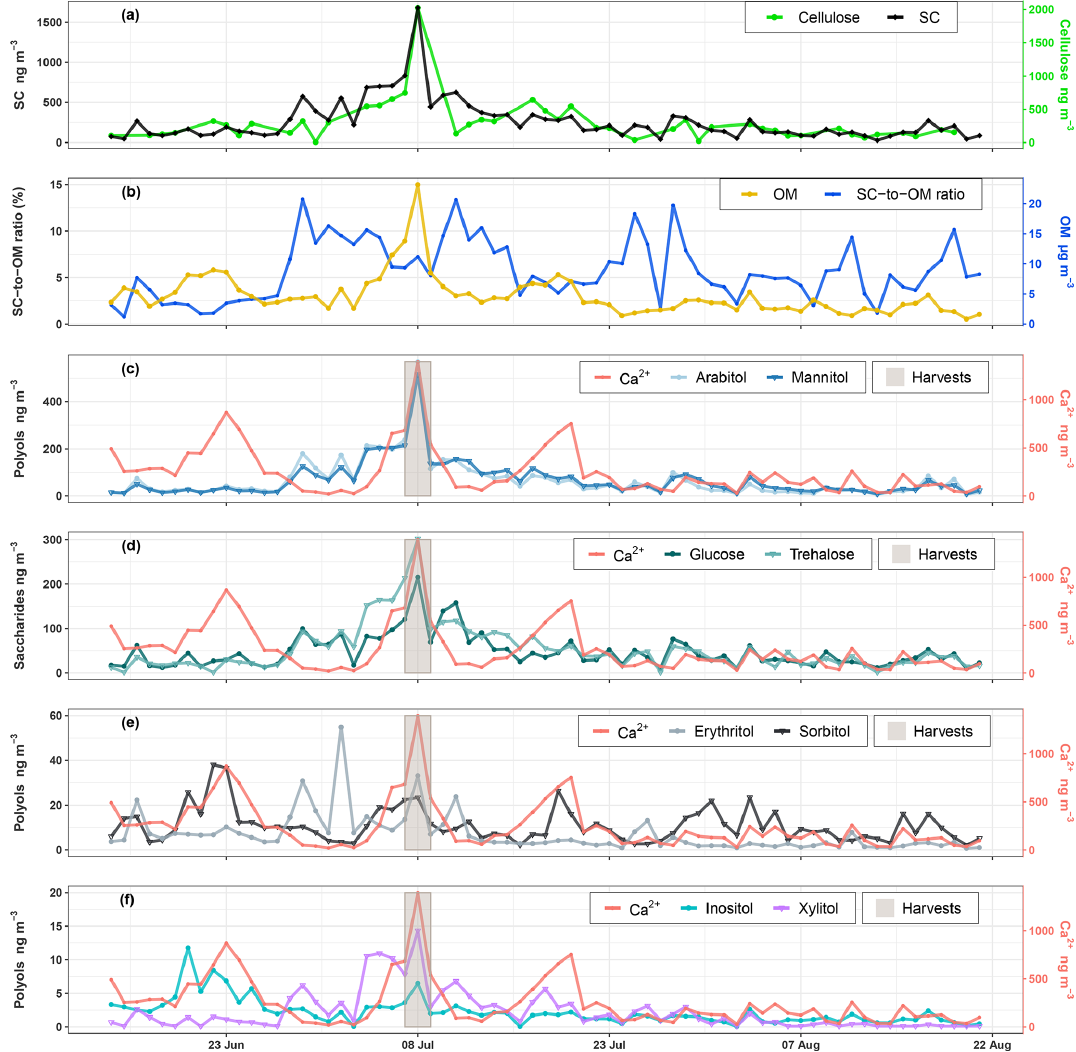
Figure 2. Ambient concentrations of carbonaceous components in PM 10 . (a, c–f) Daily variations in SC and calcium concentrations along with daily agricultural activities around the site. (b) Contribution of SCs to organic matter mass. Results for 9-week daily measurements indicate that SCs together represent a large fraction of OM, contributing to between 0.8% to 13.5% of OM mass in summer. Glycerol is not presented because its concentration was generally below the quantification